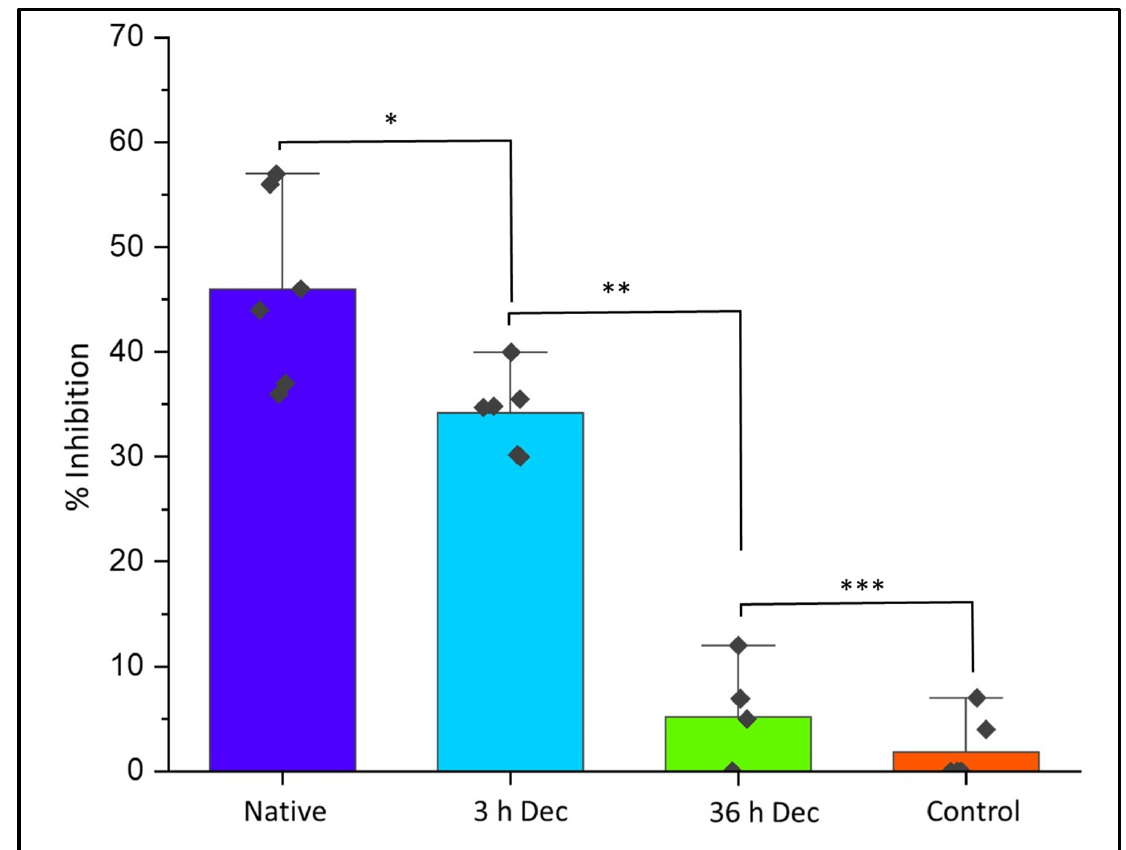
Figure 12. Assessment of the cytotoxic inhibition of chondrocytes by DACS scaffolds after various stages of decellularization. n = 6, * p -value = 0.00415, ** p -value = 1.19845 × 10 − 8 , *** p -value = 0.1998.